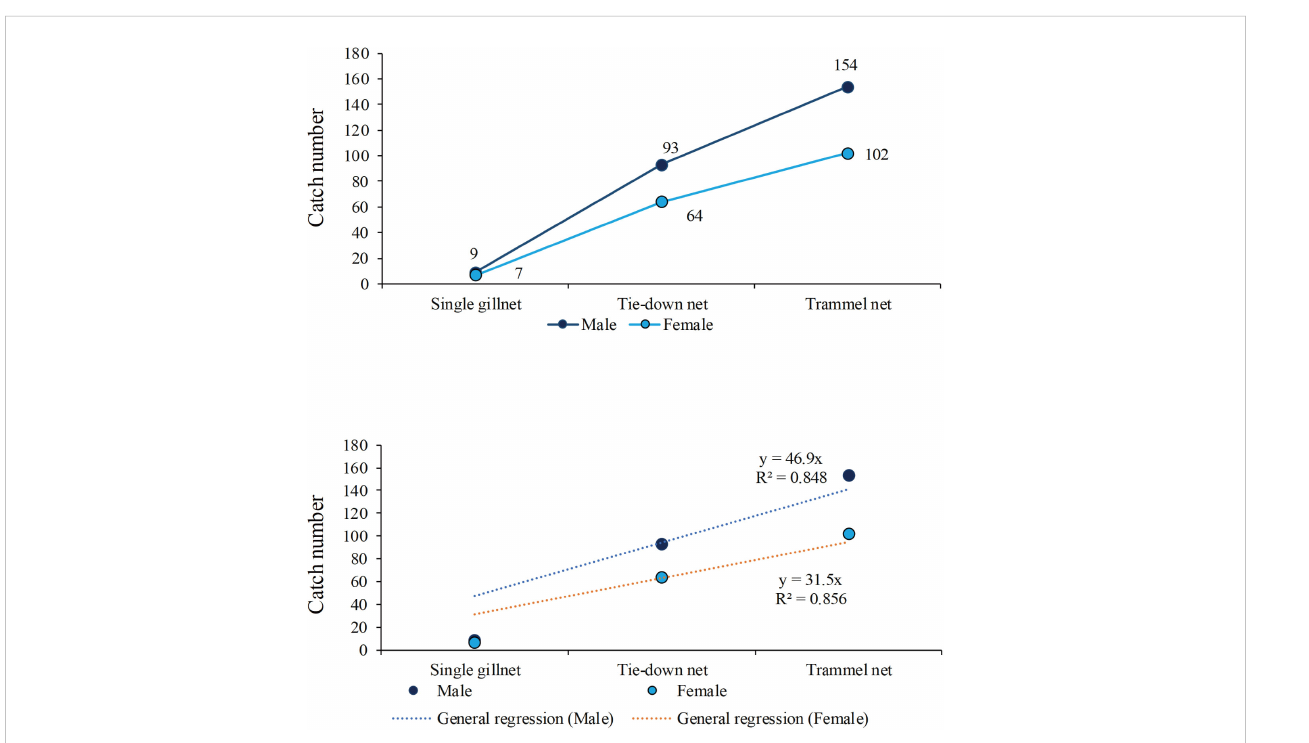
FIGURE 7 Comparison of the numbers of male and female snow crabs caught in each